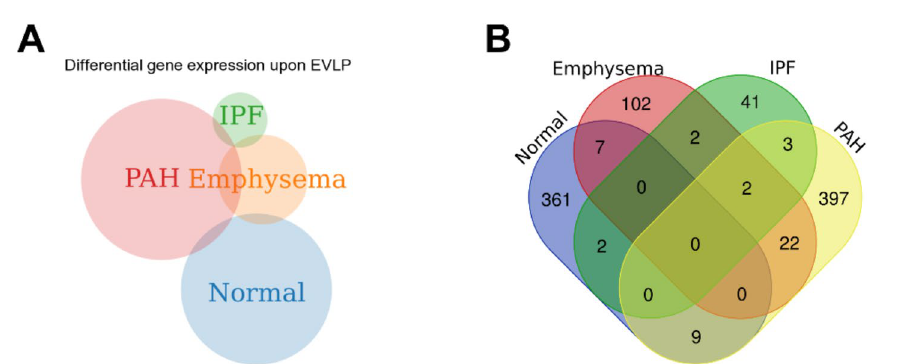
Figure 3. Cytokine measurements performed by multiplex ELISA are displayed for IL-6, IL-1β, IL-10, IFNγ, GM-CSF, IL-13, IL-7, and IL-8 ( A-H ). *p < 0.05; **p < 0.01; ****p < 0.0001.